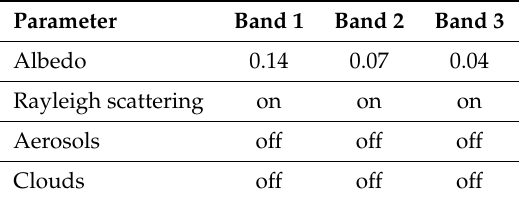
Table A6. Scattering parameters of scenario Rayleigh+Dark surface .